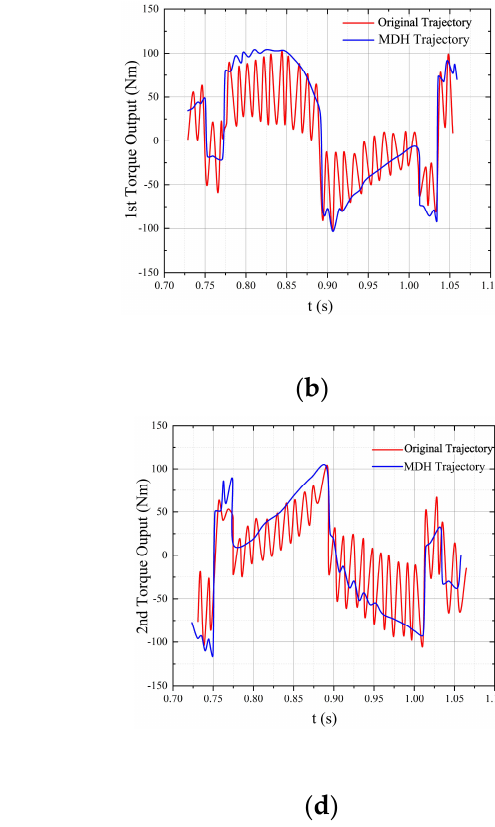
( c , d ) torque of the right Figure 12. Control behaviours of the DH and MDH control algorithms. ( a ) and ( b ) torque of the left